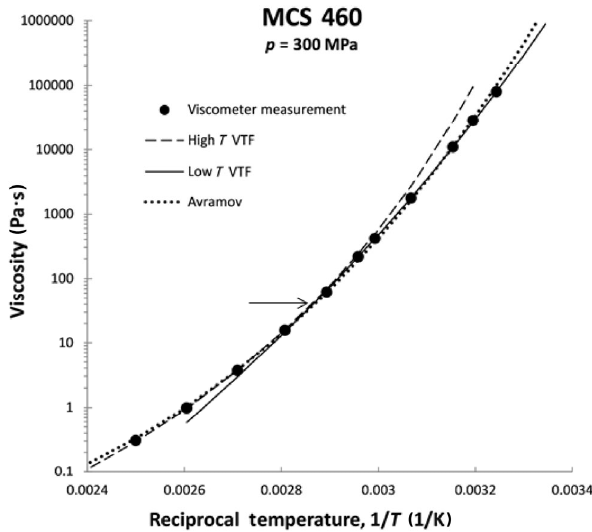
Fig. 4 The temperature dependence showing a crossover (at the horizontal arrow) which can be best represented by two VTF equations or with less accuracy by a single Avramov